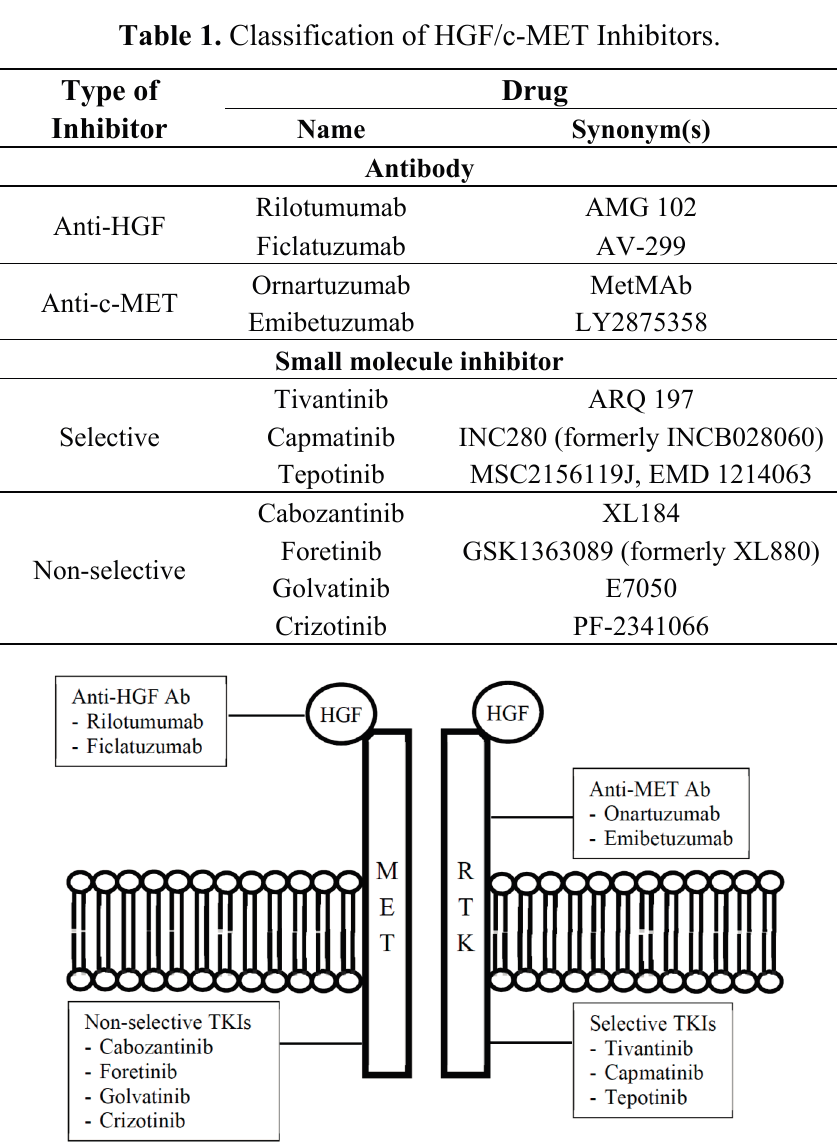
Figure 1. Classification of HGF/c-MET